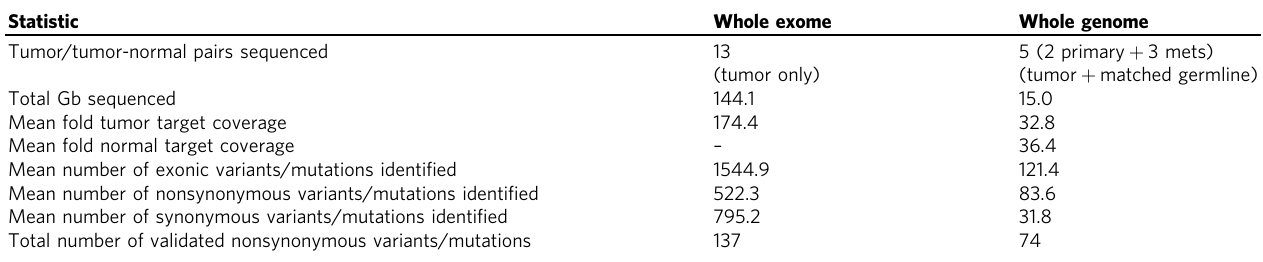
Table 1 Overview of whole-genome (WGS) and whole-exome (WES) sequencing of pineoblastoma Statistic Whole exome Whole genome Tumor/tumor-normal pairs sequenced 13 (tumor